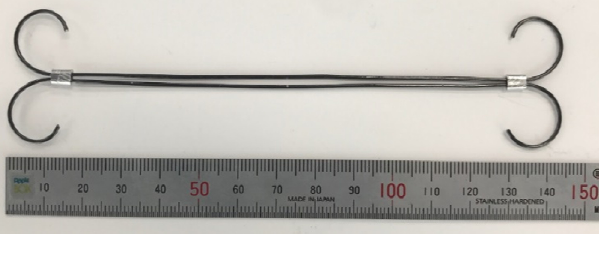
Figure 13. Hybrid SMA wire. Table 5. Separated pull-out resistance values according to mechanical